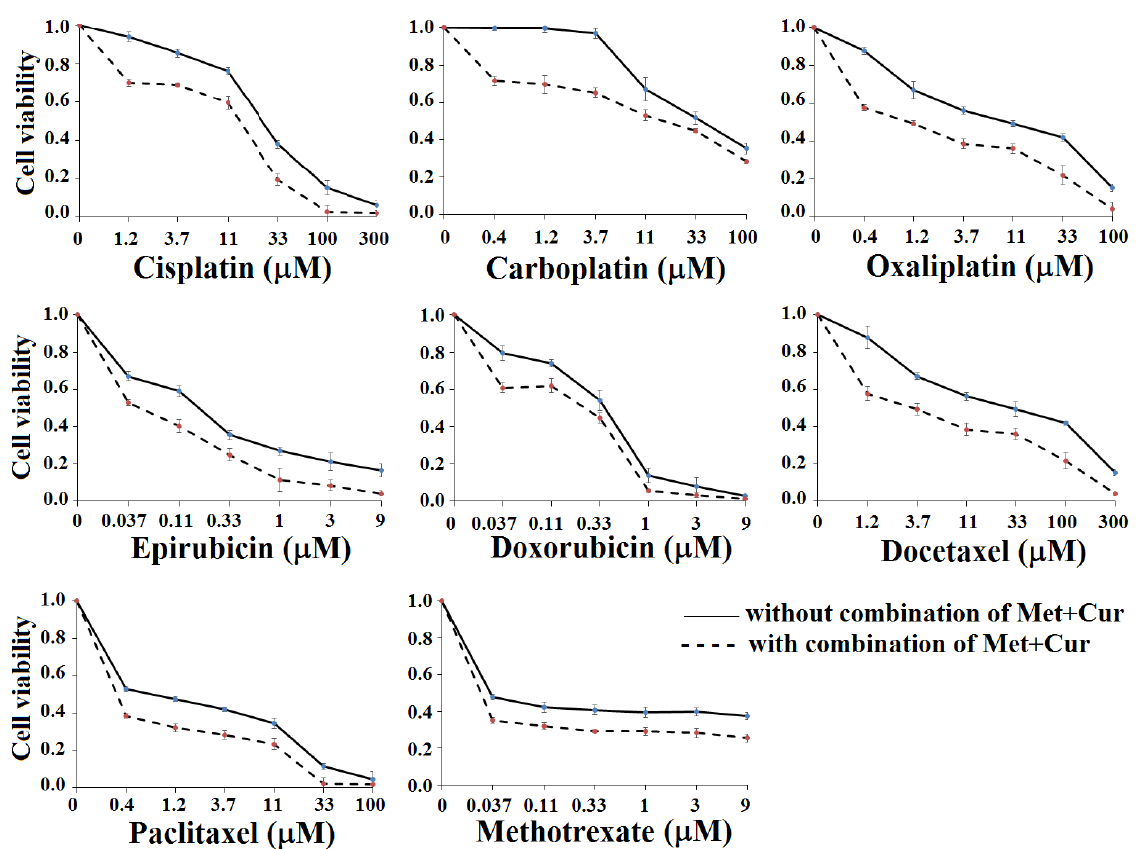
Figure 3: AGS cell line viability (mean ± SD) after treatment with 3-fold serial dilutions of anticancer drugs with or without combination of metformin (Met, 0.625 mM) + curcumin (Cur, 0.5 µM) for 48 hours. All experiments were carried out independently in triplicate. “Met + Cur” significantly increases the cyto- toxic effects of anticancer